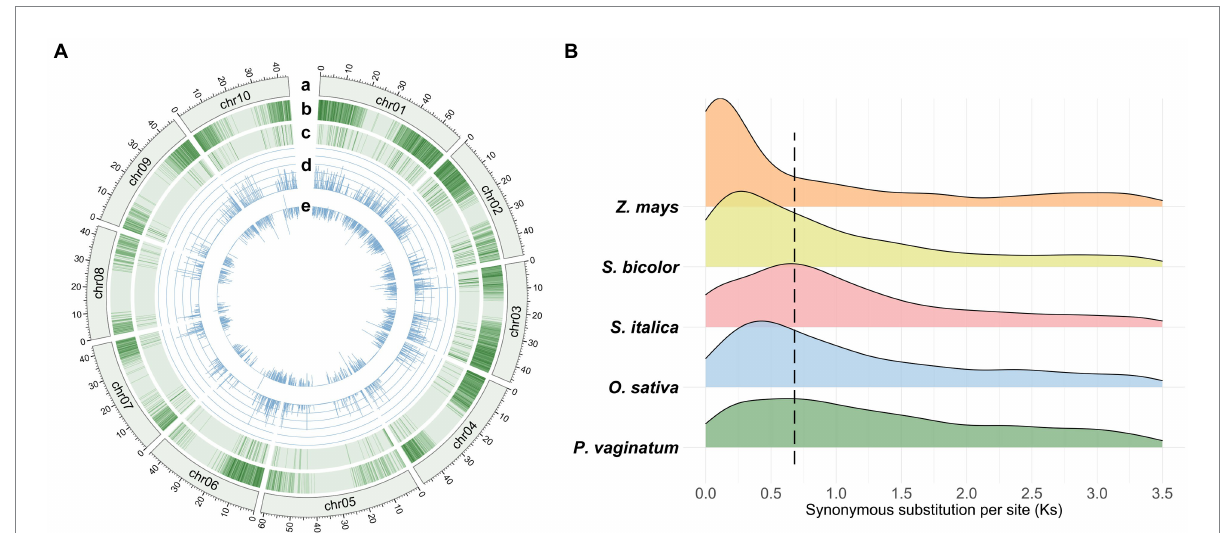
FIGURE 1 Overview of the Paspalum vaginatum genome and comparison of Ks. (A) Tracks from outer (a) to inner (e) rings indicate the following: (a) Chromosome size with units in Mb; (b) density of genes; (c) density of TDGs; (d) Ks of TDG pairs; (e) Ka/Ks values of TDG pairs and normalization by log2 (Ka/Ks). (B) Distribution of Ks calculated by TDG pairs between study